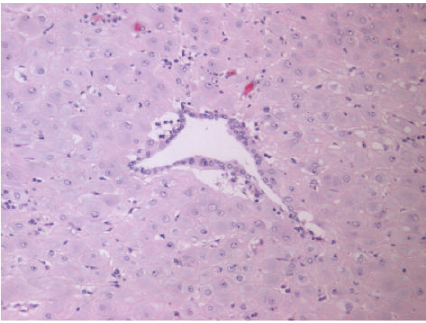
Figure 2: Endometriosis H&E × 100. A central endometrial gland surrounded by abundant decidualised endometrial stroma.